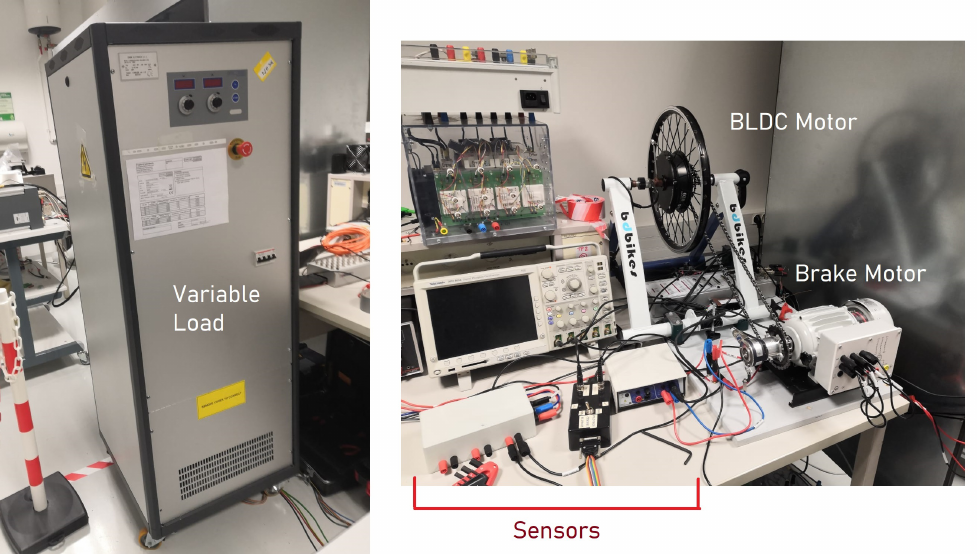
Figure 5. Practical Test bench